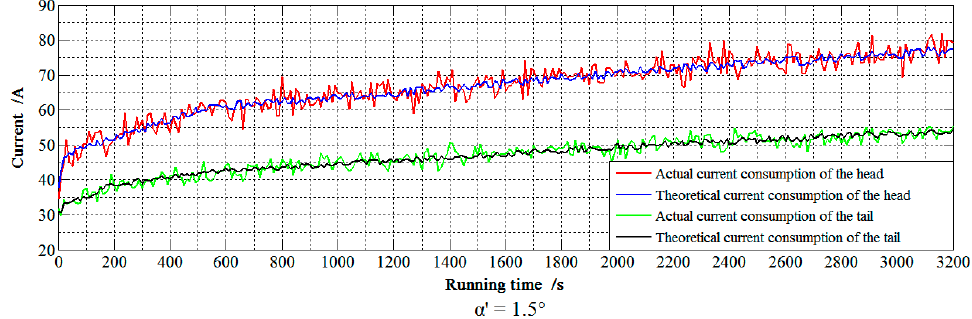
Figure 8. Comparison between the measured and theoretical current of scraper conveyor when m =1.